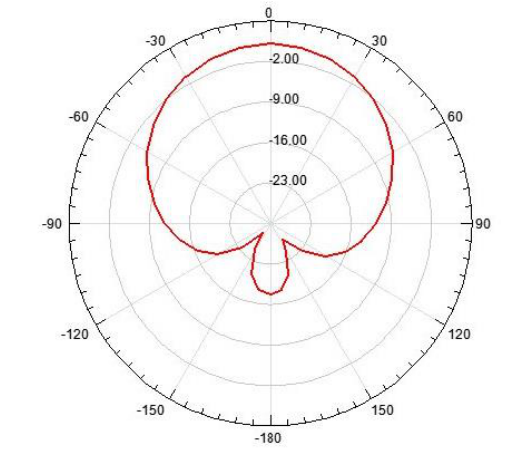
Fig. 1.14 2D Radiation Pattern of the Antenna 3